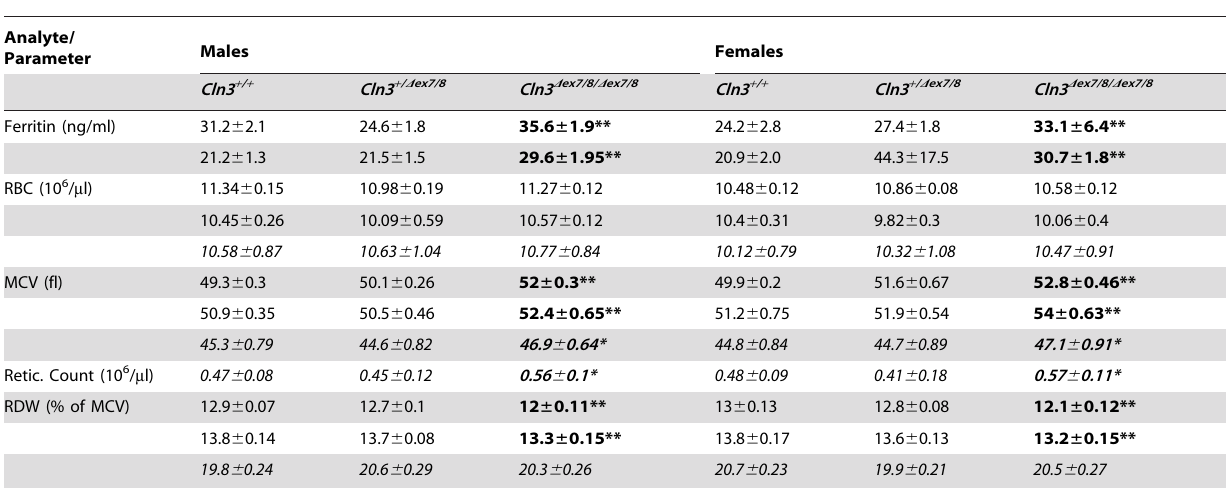
Table 3. Blood analysis of Cln3 D ex7/8 mice.